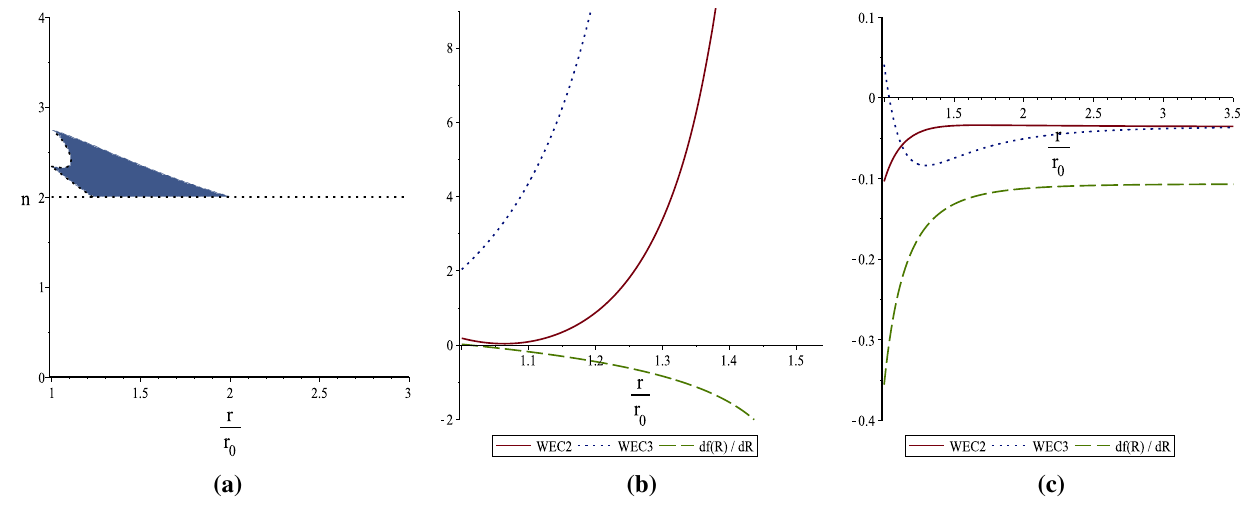
n = 2 . 3. In c by setting n = 5 we show an example for violation of the NEC in the case of asymptotically spherical wormholes in this model. We set the parameters as p = 1 / 2 , R ∗ = 0 . 1 ,μ = 20 , r 0 = 0 . 3 (μ =